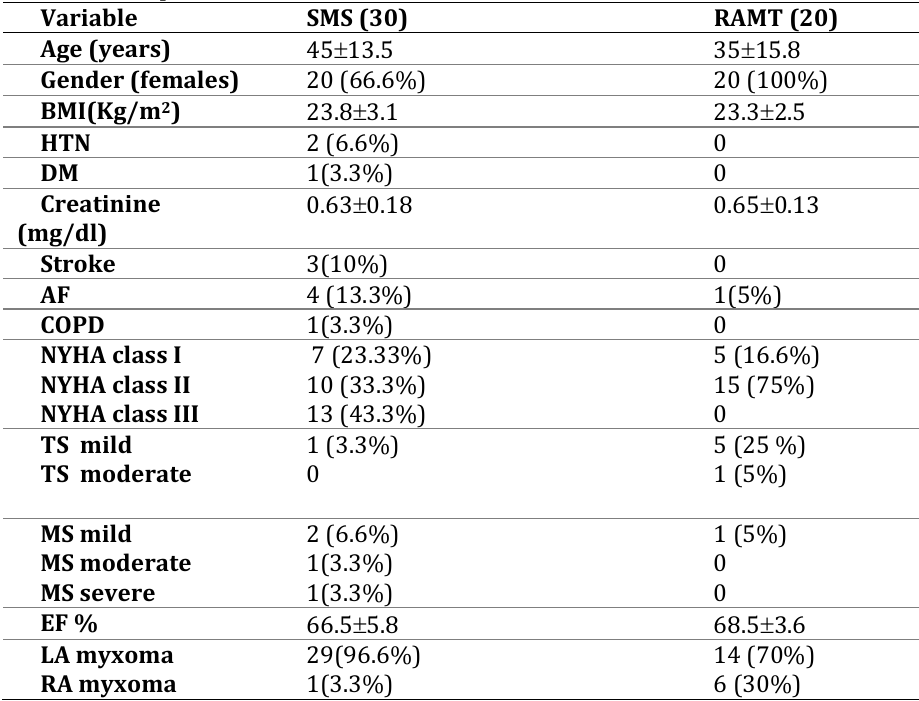
Table 1: Preoperative clinical data